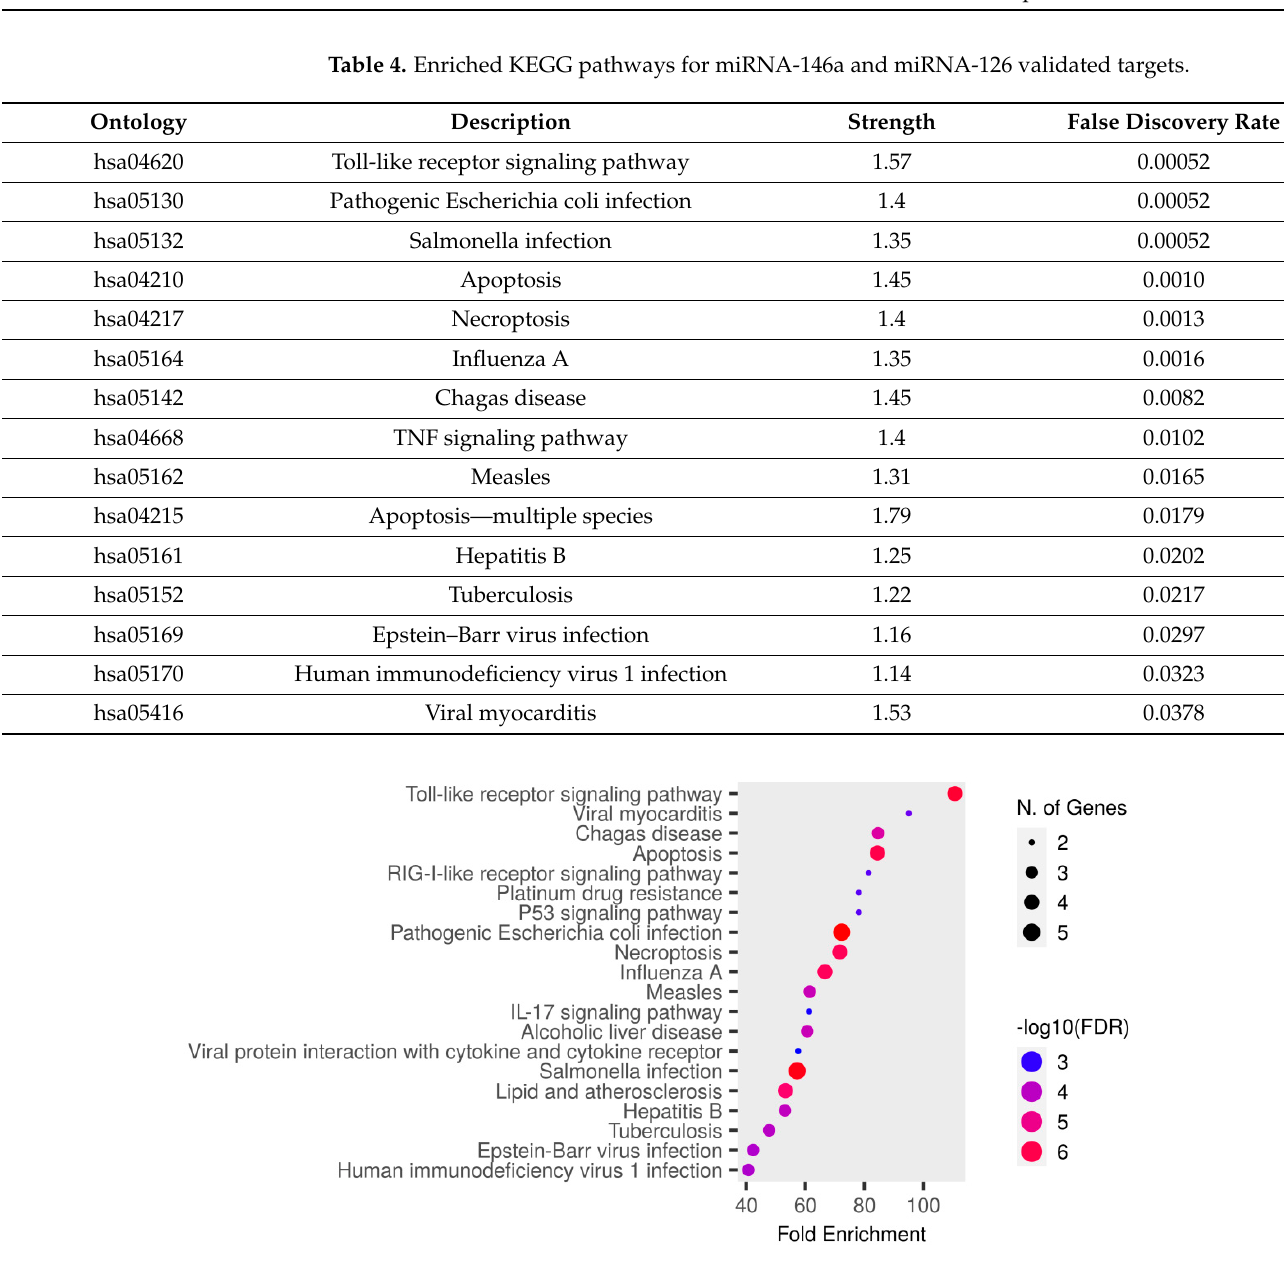
Figure 5. Dot plot showing the results of KEGG pathway enrichment analyses performed for miRNA-146a and miRNA-126 validated targets. N. of Genes- number of genes. The most significant enriched pathway was the Toll-like receptor signaling path- way, including four of the analyzed genes: TOLLIP , FADD , CASP8 , and IRAK1 (Figure 6). Figure 6. Toll-like receptor signaling pathway including miRNA-146a and miRNA-126 validated target genes (highlighted in red), according to the KEGG database. Gene Ontology (GO) analysis was conducted to assess the involvement of the miRNA-146a and miRNA-126 validated target genes in the relevant biological process (BP), cellular component (CC), and molecular function (MF)—which are all summarized in Figure 7. Molecular function pathways were enriched by the next most significant pathways: death effector domain binding, TRAIL binding, NF-kappaB-inducing kinase activity, tumor necrosis factor receptor binding, and cytokine receptor binding (Figure